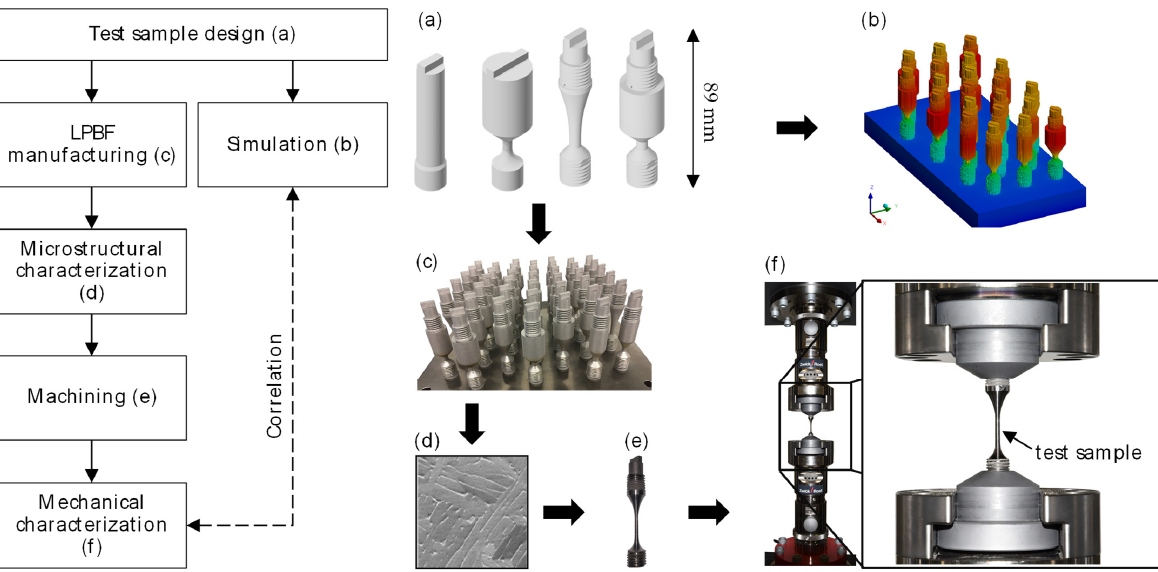
Figure 1. Methodology to determine the geometry effect on material properties and correlation with simulation results, ( a ) exemplary sample geometries with a varied cross-sectional area, ( b ) LPBF process thermal simulation of sample manufacturing, ( c ) exemplary LPBF-manufactured samples, ( d ) exemplary microstructure at investigation point in manufactured sample, ( e ) machined sample with uniform cross section for mechanical testing, ( f ) sample installed in tensile testing machine.